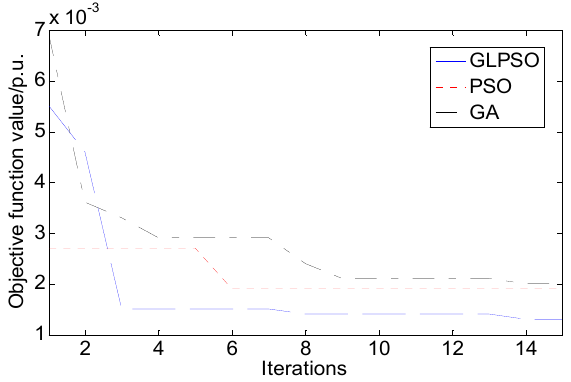
Figure 6. Comparison of three algorithms.